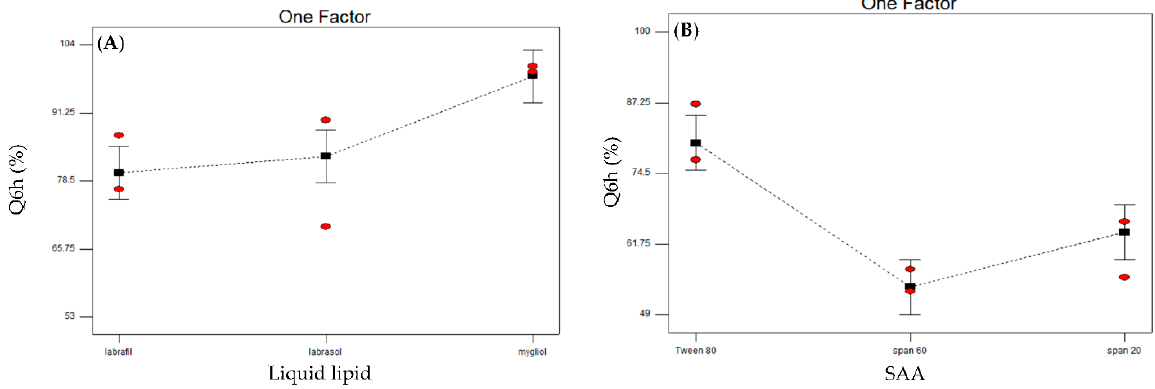
Figure 4. Line plots of the effect of the two significant studied variables: liquid lipid type ( A ) and surfactant type ( B ) on in vitro release.